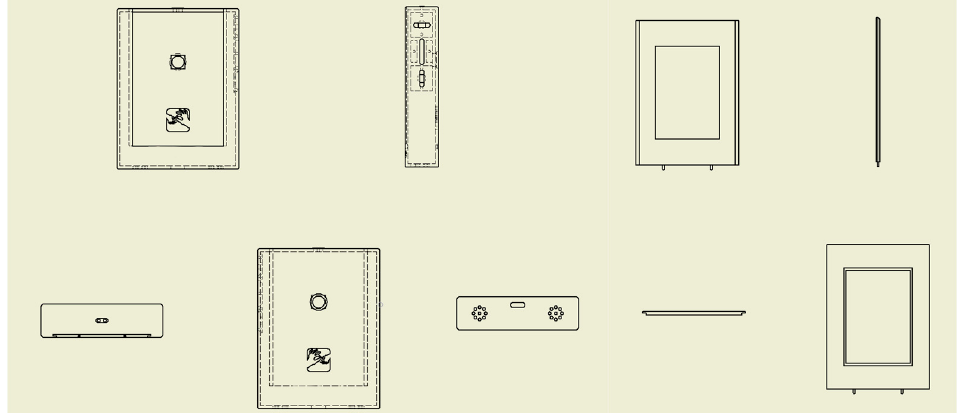
Figure 3. Heart-Speaker shell structure design.